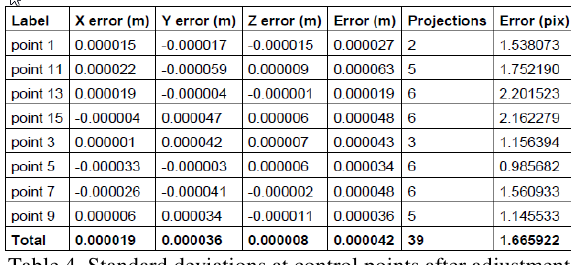
Figure 3. Image of figurine during measuring of control points. At the end of phototriangulation the standard deviation at control points in reference coordinate system, as well as in image coordinate system are given in table below: